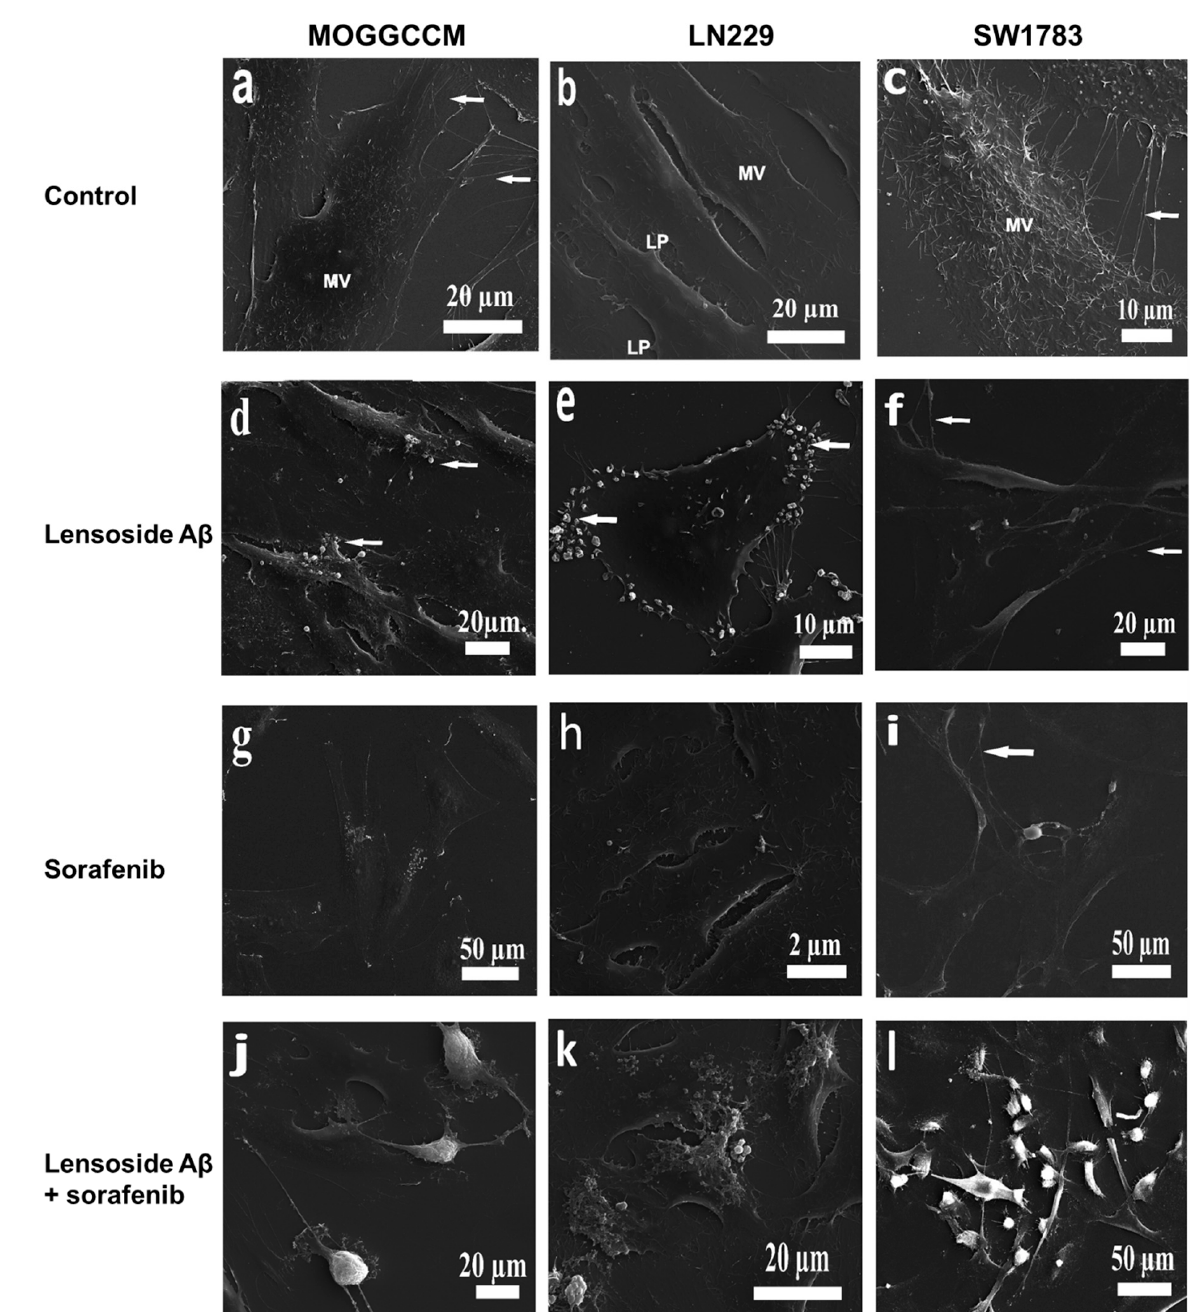
Figure 9. MOGGCCM, LN229, and SW1783 cells examined by scanning electron microscopy (SEM): ( a – c ) control cells; ( d – f ) lensoside A β -treated cells; ( g – i ) cells incubated with sorafenib; ( j – l ) combined treatment with lensoside A β and sorafenib. ( a ) Adherent MOGGCCM cells presenting microvilli on the surface and thin processes joining neighboring cells (arrows). ( b ) LN229 cells with scarce microvilli (MV) and lamellipodia (LP). ( c ) SW1783 cells exhibiting single shorter and longer filopodia and thin, long projections between adjacent cells (arrows). Cells are covered by dense microvilli (MV). ( d ) MOGGCCM cells after lensoside A β treatment showing blebs (vesicles) on the surface of the cells (arrows). ( e ) LN229 cells with altered peripheries of the cell (arrows) after lensoside A β treatment. ( f ) SW1783 cells connected by TNT-like processes with vesicles. ( g ) Ruffles and small vesicles on the surface of MOGGCCM cells. ( h ) LN229 cells showing microvilli on the surface of the cells. ( i ) SW1783 cells with no microvilli and long interconnections between cells (arrow). ( j ) MOGGCCM cells with apparent long TNT-like processes and LP (lamellipodia). Cells exhibit globular-shaped bodies. ( k ) LN 229 cells presenting microvesicles, blebs, and ruffles on the surface. ( l ) SW1783 cells with microvesicles on the edges and blebs formed. Some cells show a normal topography.